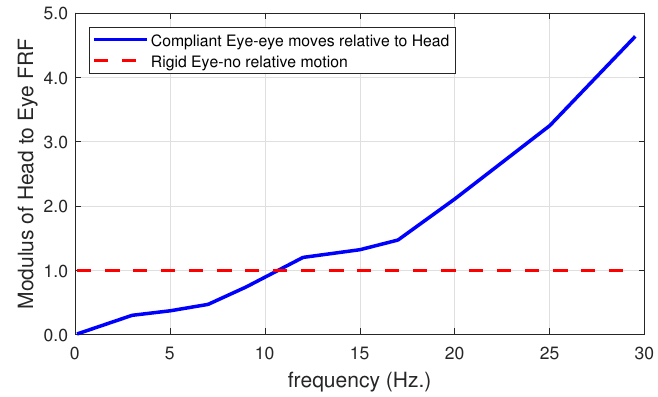
Figure 5. Modulus of the head to eye frequency response function.